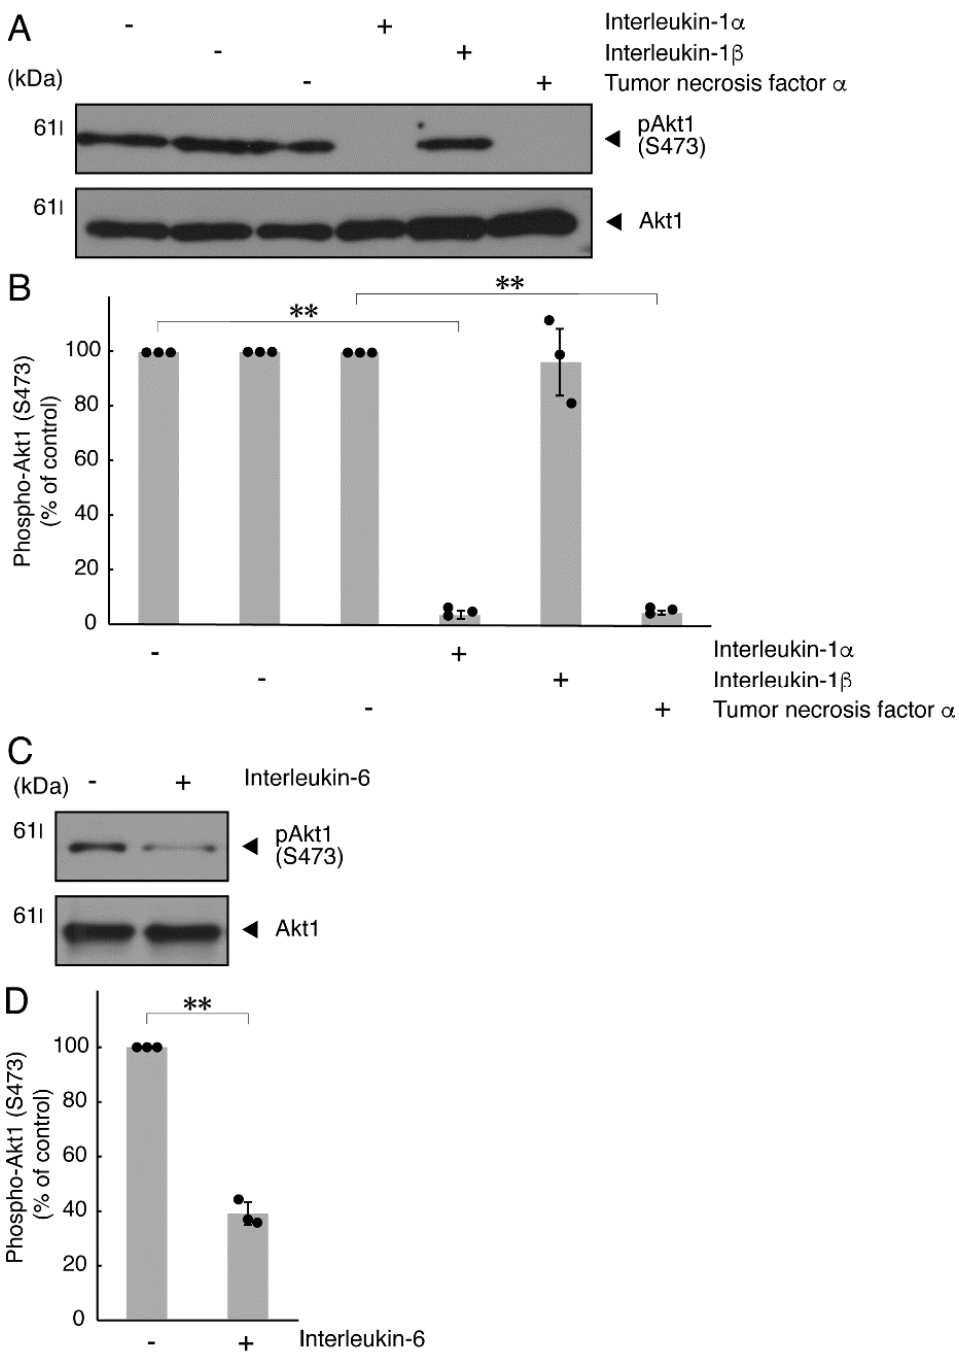
Figure 5. TNF α or IL-6 inhibits phosphorylation of Akt kinase. ( A , B ) Cells were treated with control vehicles (-), interleukin-1 α (IL-1 α as a positive control)/interleukin-1 α (IL-1 β as a negative control) or tumor necrosis factor α (TNF α ). The (pS473)Akt1 or Akt1 blot is shown. Immunoreactive band intensities for (pS473)Akt1 were also compared to be depicted in graphs (**, p < 0.01; n = 3 blots [obtaining one sample each from 3 independent experiments]). ( C , D ) Cells were treated with control vehicles (-) or interleukin-6 (IL-6). The (pS473)Akt1 or Akt1 blot is shown. Immunoreactive band intensities for (pS473)Akt1 were also compared to be depicted in graphs (**, p < 0.01; n = 3 blots [obtaining one sample each from 3 independent experiments]). The vertical values in graphs were evaluated as (pS473)Akt1/total